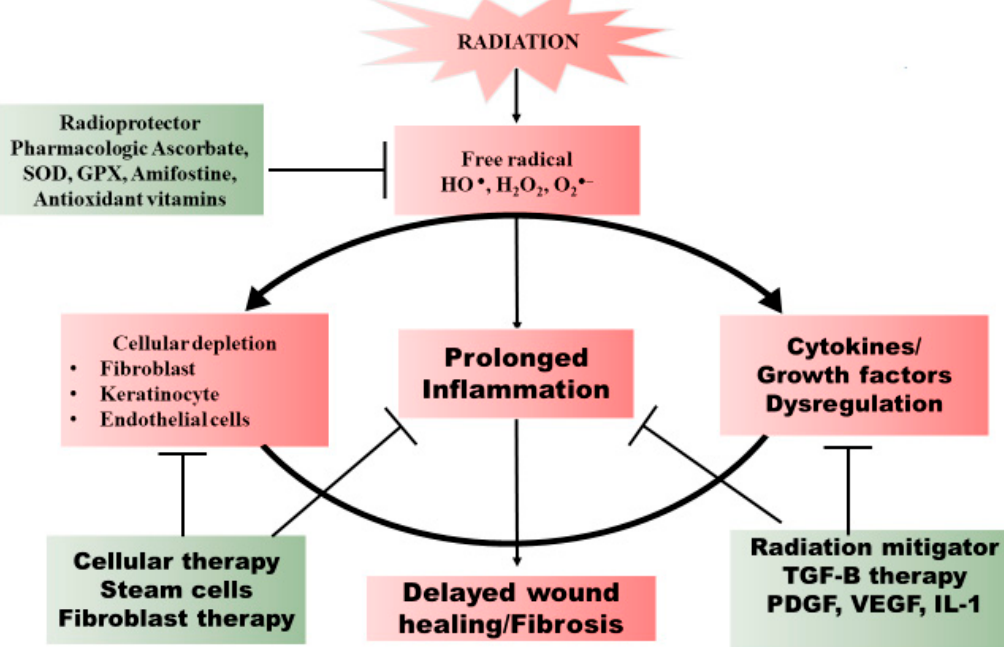
Figure 3. Summary of the key steps in wound healing dysregulated by radiation and the prospective therapeutic intervention of the events.